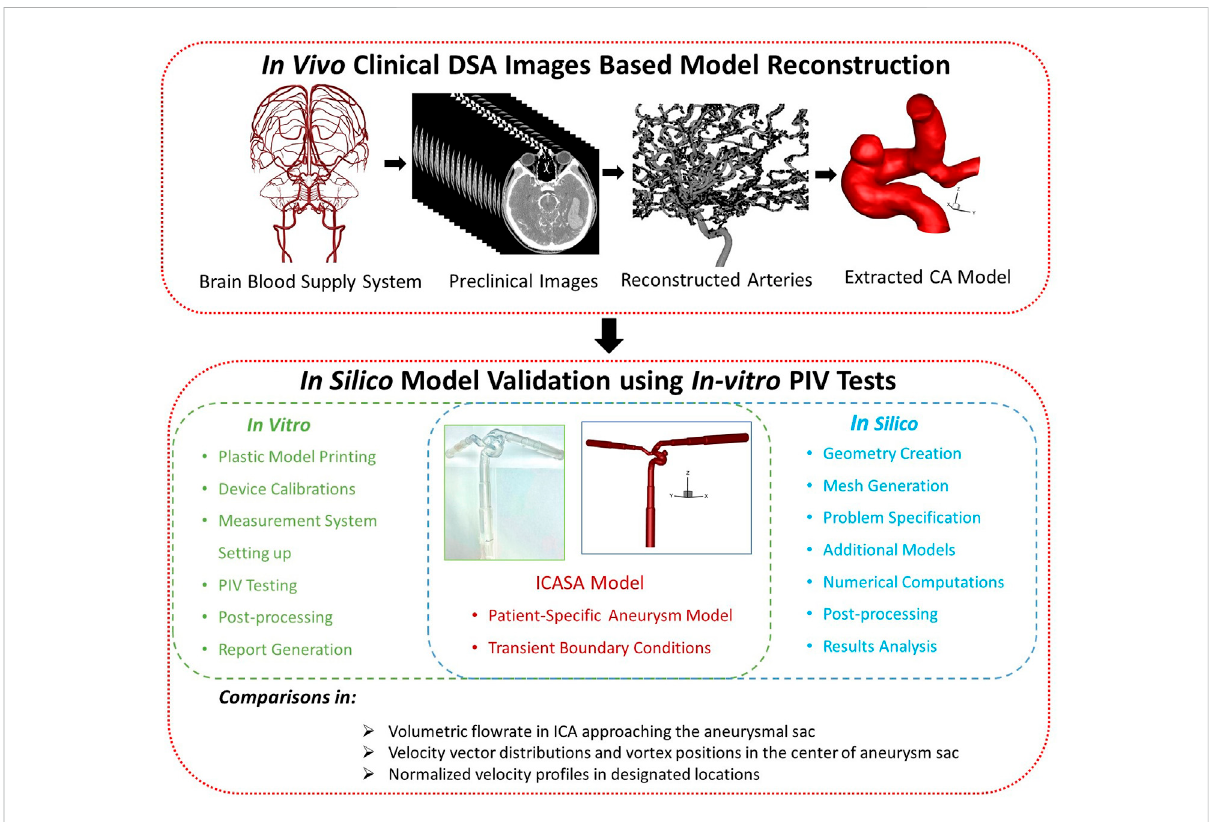
FIGURE 1 The framework of in vitro validated in silico study in the ICASA